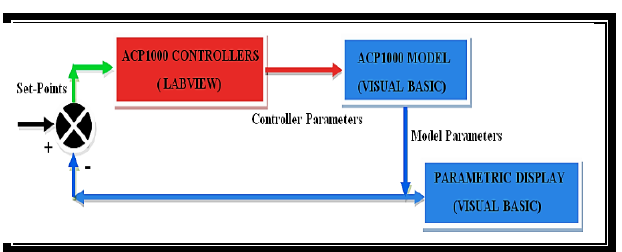
Fig. 6 . Closed loop coupled interfaced configuration